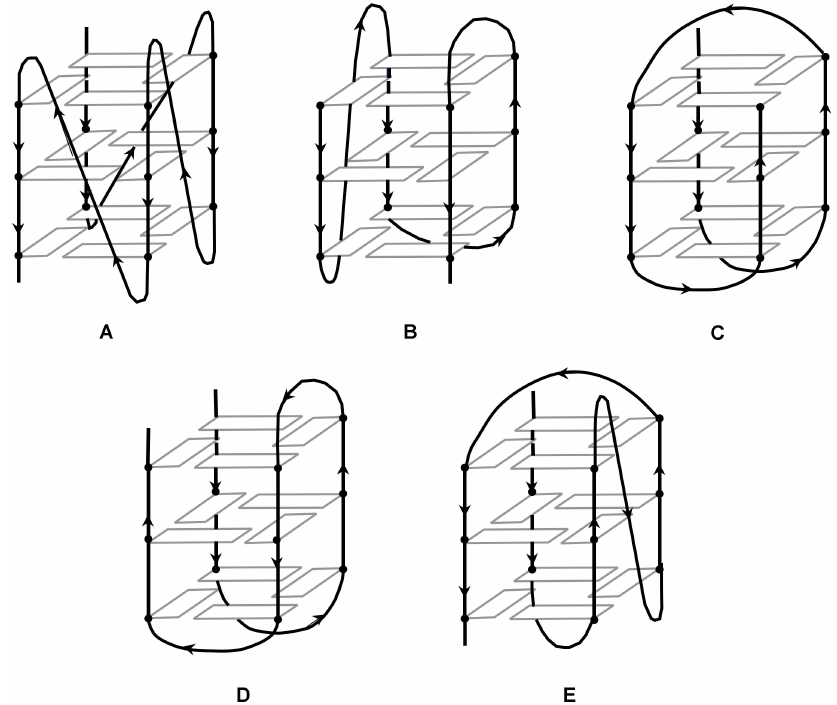
Figure 2. Schematic representation of various topologies adopted by simple unimolecular G- quadruplexes. ( A )—Parallel conformation with three double chain reversal loops. ( B )—Antiparallel conformation with one double chain reversal loop and two side loops. ( C )—Antiparallel conforma- tion with two side loops and a diagonal loop. ( D )—Antiparallel conformation with three side loops. ( E )—Antiparallel conformation with two diagonal loops and a double chain reversal loop